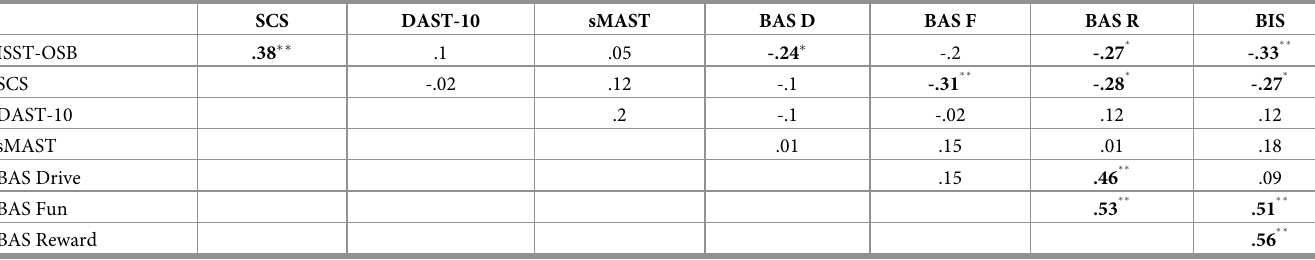
Table 3. Pearson’s correlations between psychometric